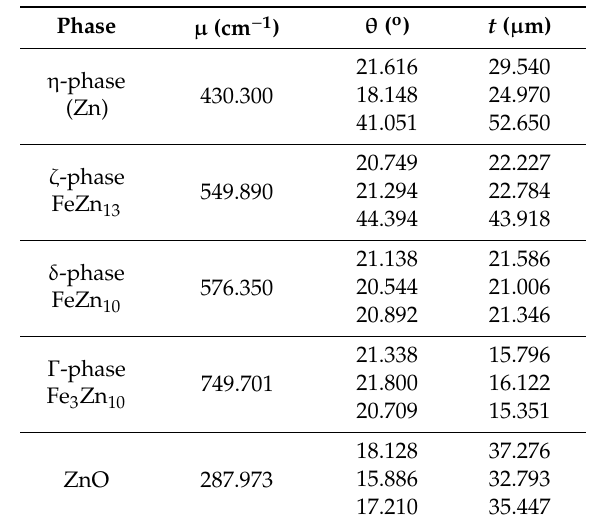
Table 1. The linear attenuation coefficients of Zn, ZnO and Zn–Fe compounds and the penetration depth of X-rays in BB-XRD calculated using Equation (5).